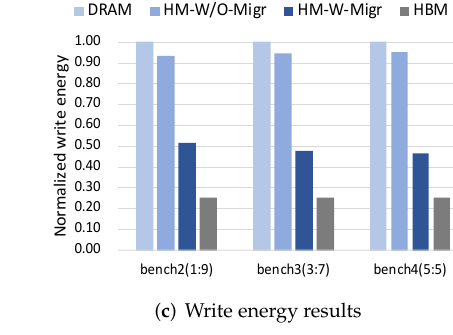
Figure 9. Normalized results across different set-get operation